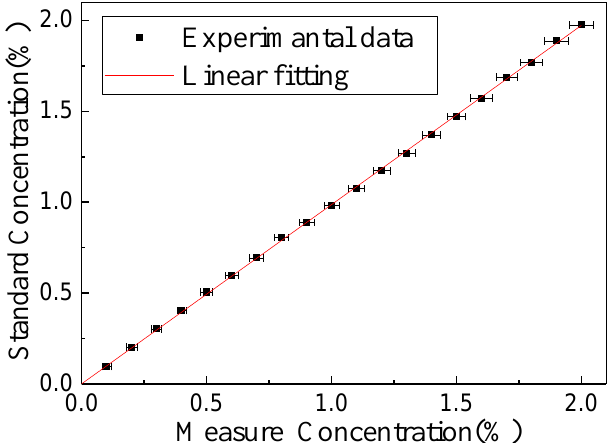
Figure 11. Fitting curve of the measured and standard concentration.